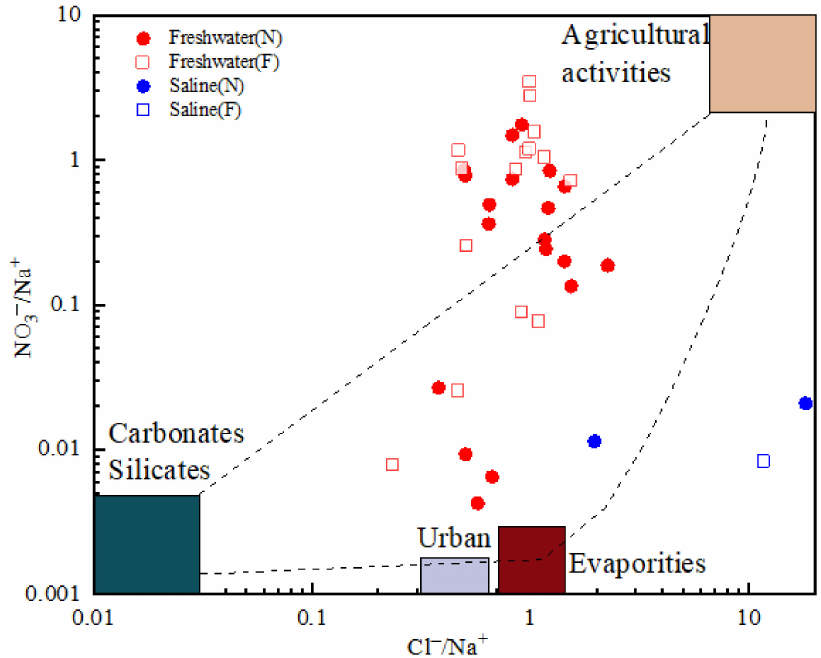
Figure 7. Plot of the source of NO 3 − among NO 3 − /Na + versus Cl − /Na + in groundwater. The lower left square area represents carbonates silicates, the upper right square area represents the agricultural activities and the lower middle square area represents urban and evaporities, respectively. Most groundwater is affected by agricultural